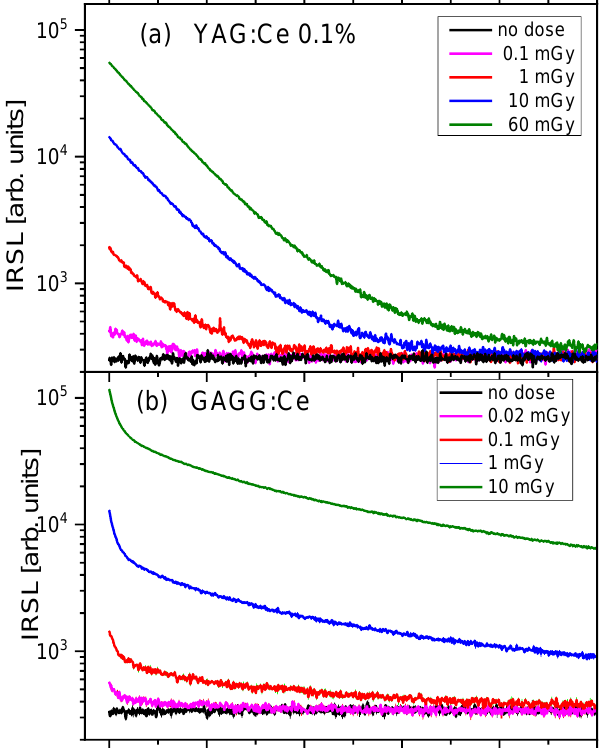
Figure 16. Dose-response for YAG:Ce 0.1% crystal, compared with that of GAGG:Ce crystal. The doses up to 10 mGy were delivered with 137 Cs gamma-rays, while the higher doses with 9 °Sr/ 9 °Y beta-particles. Lines indicate linear trends. 020406080100